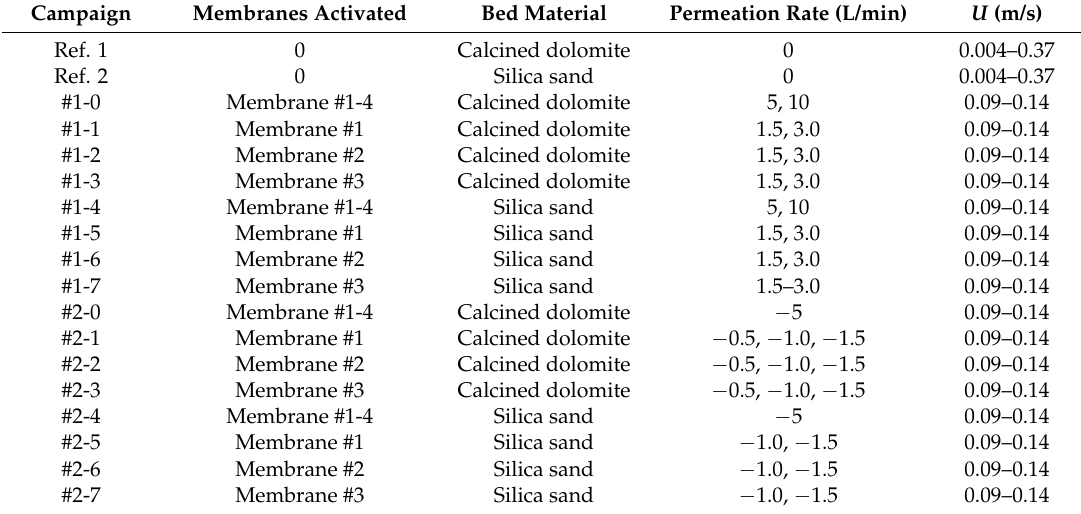
Table 2. Operational conditions of experiments